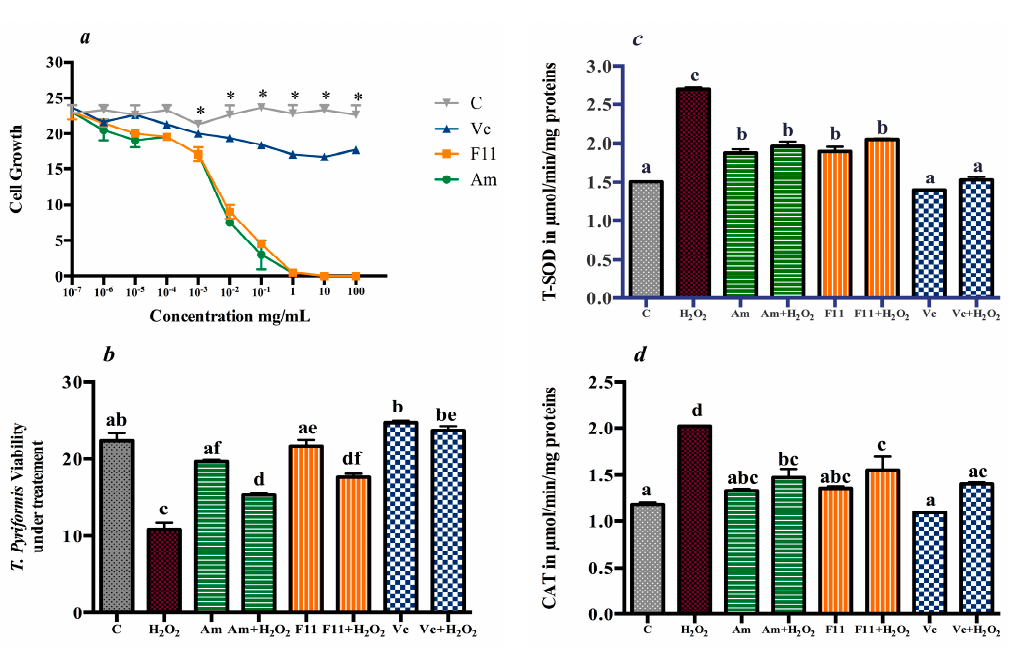
Figure 1. Oat protective effect on antioxidant enzymes under oxidative stress in T. pyriformis. ( a ) Oat and Vitamin C effect on T. pyriformis growth. ( b ) T. pyriformis viability under H 2 O 2 treatment in the presence of extracts. ( c ) T-SOD levels T. pyriformis cultures. ( d ) CAT levels T. pyriformis cultures, Data are reported to mean ( n = 3) ± SD. Values not sharing a common letter (a–d) differs significantly at p < 0.05. ( * ) differ significantly from the control.